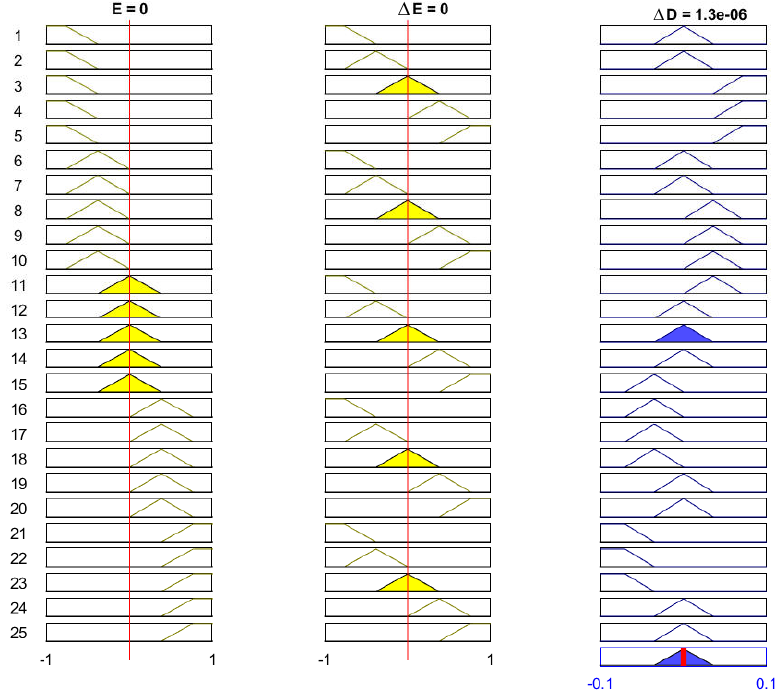
Figure 6. The 25 fuzzy rules (If-Then rules), which relates the inputs and the outputs of FLC